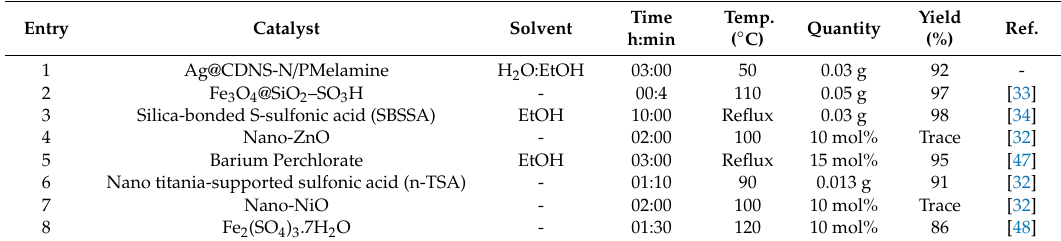
Table 5. The comparison of the catalytic activity of the catalyst with some other reports for the synthesis